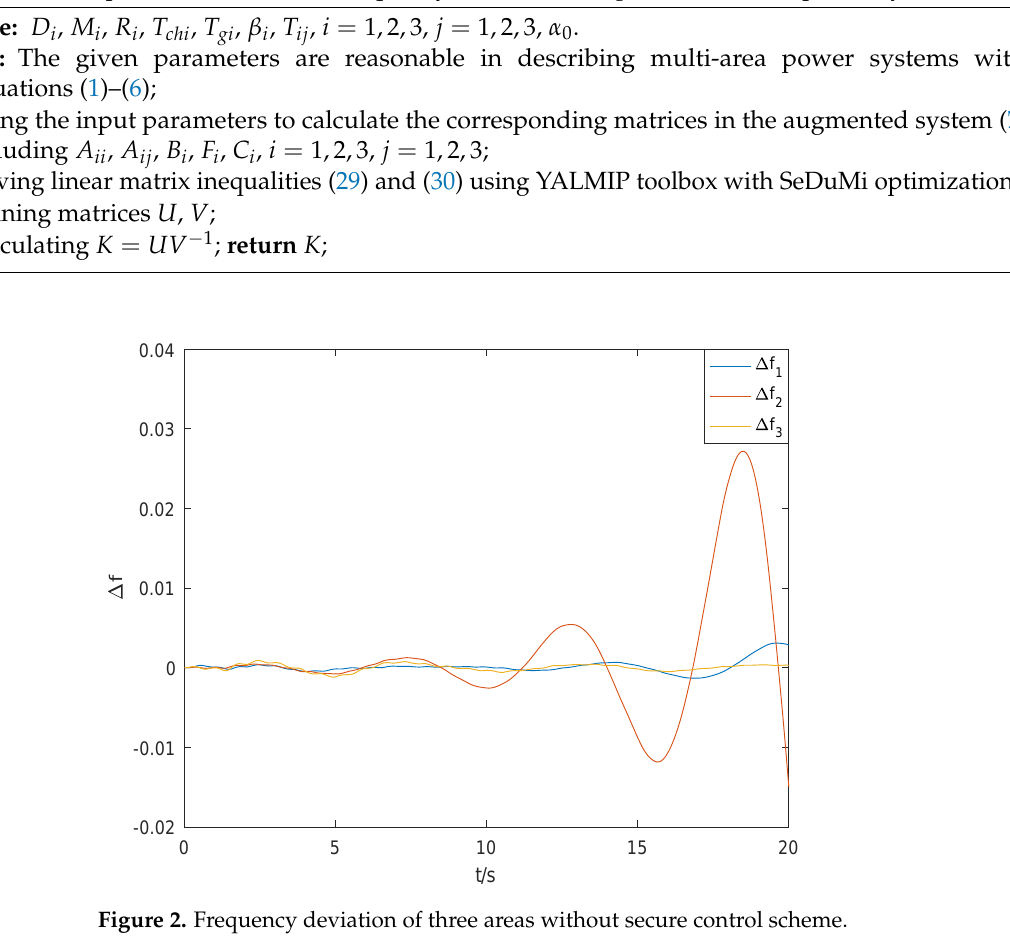
Algorithm 1 Output feedback PI load frequency controller design for three-area power systems.